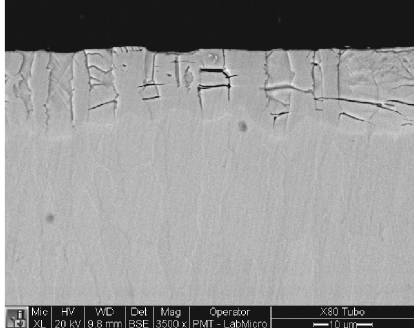
Figure 3. Nitrided layer obtain at 450 °C.